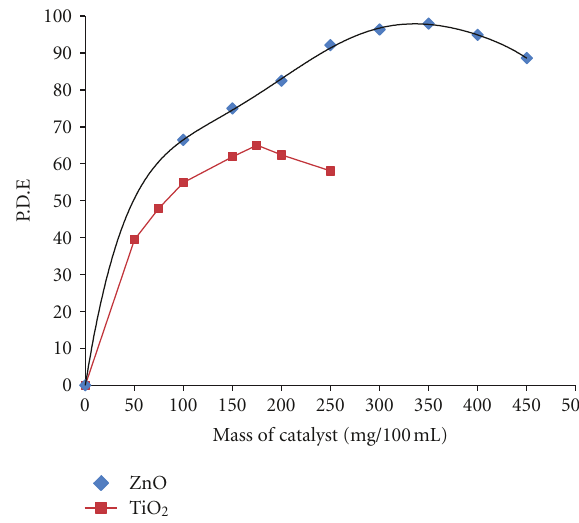
Figure 2: E ff ect of the masses of catalyst on photodecolorization e ffi ciency of